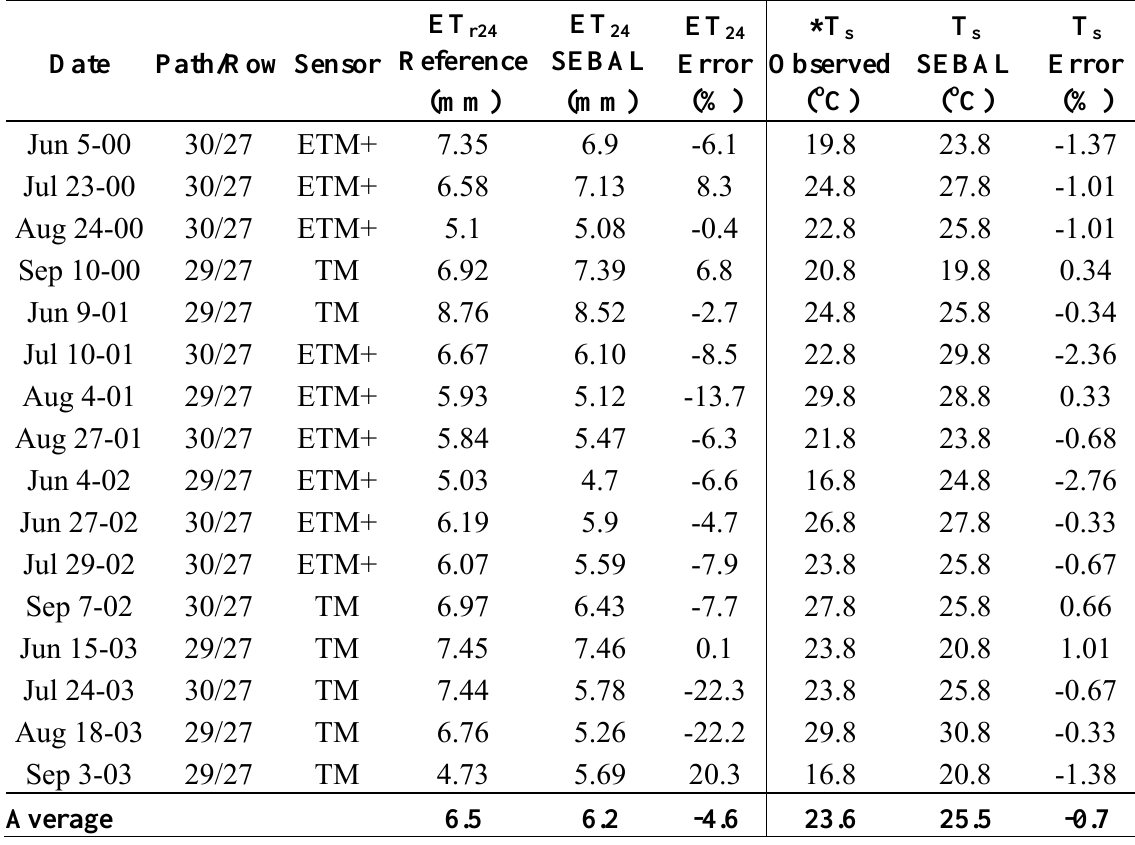
Table 1. Comparison of the surface energy balance approach and observed 24-hr reference ET at the Glacial Ridge wetland, Minnesota.